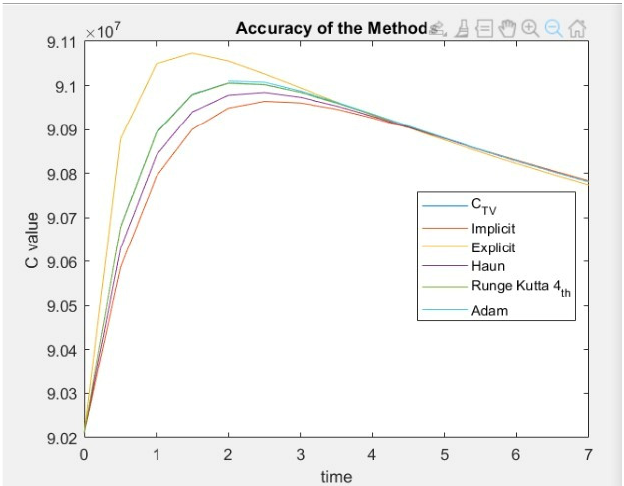
Figure 8. Comparison between the results of all the methods, where 𝐶 is the number of diabetic patients with complications and 𝐶 (cid:3021)(cid:3023) is its true value.